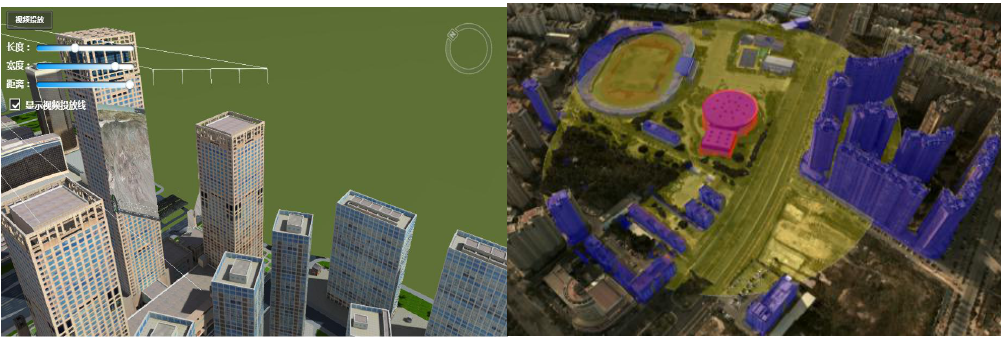
Fig.8 video placement and spatial topology